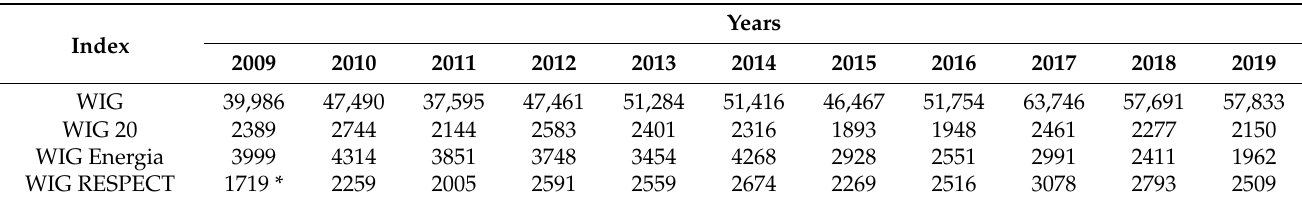
Table 1. Selected indices of the Warsaw Stock Exchange in the years 2009–2019 rounded to the full point (as at the end of the year).